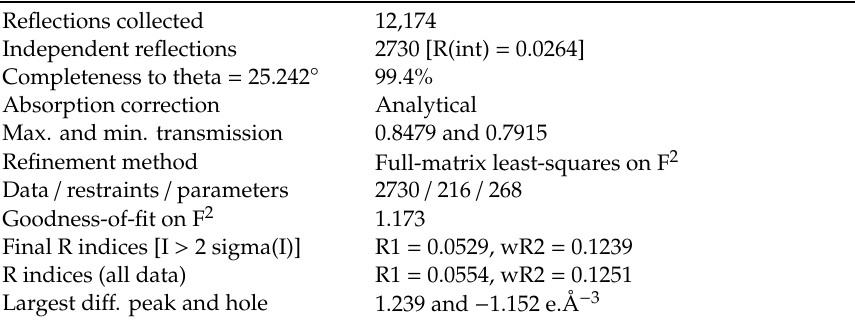
Figure 2. Dinuclear secondary building unit (SBU) and the 2D coordination array in 1 . Figure 3. The 3D packing diagram of 1 constructed by π–π stacking interactions .